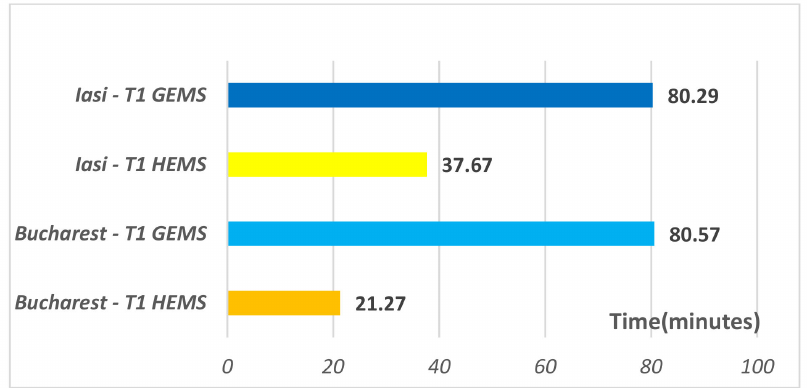
Figure 1. Response time (T1) when taking the patient from the emergency department for transfer by air or